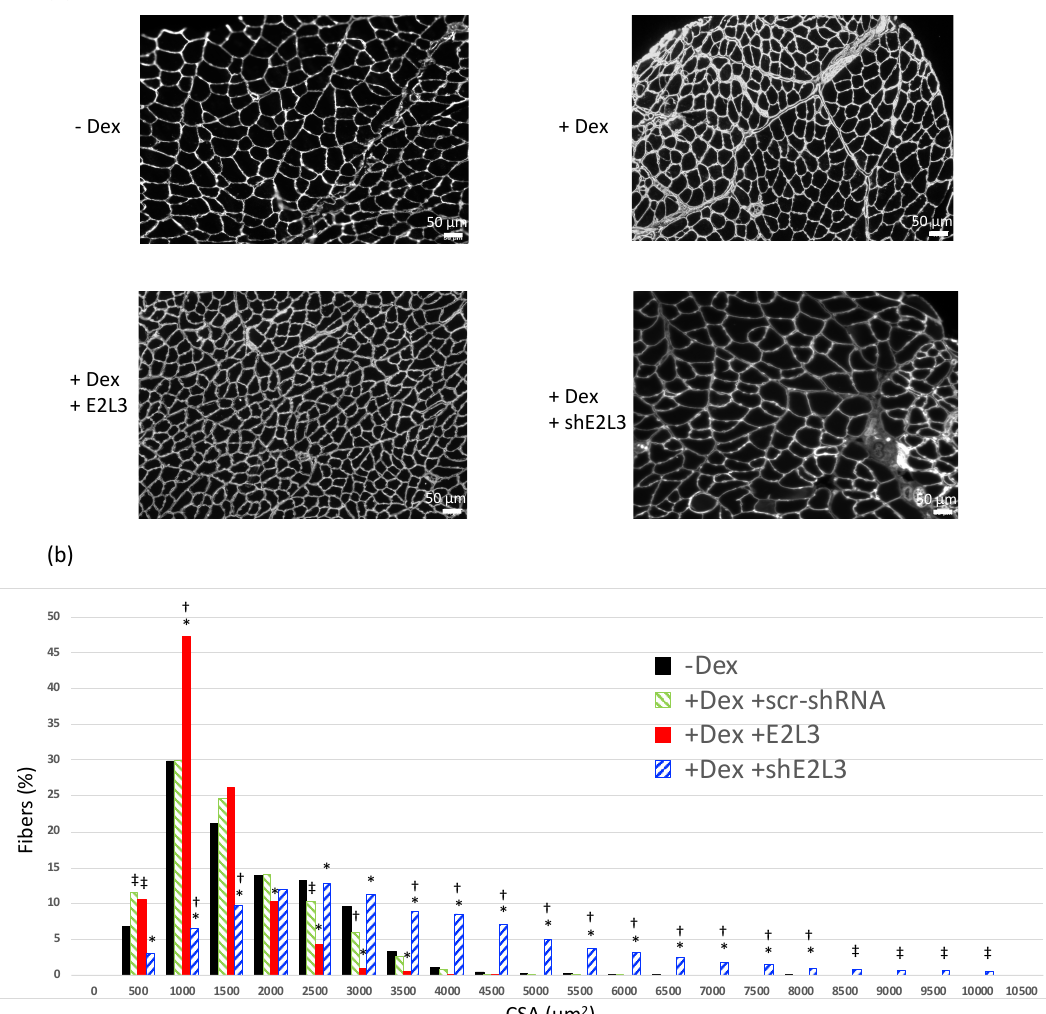
Figure 2. E2L3 KD and overexpression modify myofiber cross-sectional area (CSA). Mice treated or not with Dexamethasone (Dex 5 mg/kg/day) were transfected with either a scramble shRNA (scr-shRNA) targeting no known coding sequence, a mixture of two shRNAs (siE2L3, knockdown) directed against E2L3 or a plasmid encoding for E2L3 (E2L3, overexpression). Sh-encoding plasmids also encoded for emGFP, which allowed us to estimate the efficiency of transfection (typically around 50%; see Supplementary Materials Figure S2). Tibialis anterior muscle cross-sections were labeled with anti-laminin- α 1 for determining CSA (see Section 2 for details). Four different zones and a minimum of 380 fibers were used for each muscle. ( a ) Representative cross-sections of T. anterior from each group are shown. Scale bar, 50 µ m. ( b ) CSA analysis from n = 6 mice and a total of 17,945 fibers were analyzed, using a one-way ANOVA. Fibers distribution was analyzed within each muscle by grouping CSAs by 500 µ m 2 steps. A global shift towards lower CSA was observed when E2L3 was overexpressed in muscles. By contrast, larger CSA were observed in E2L3 KD muscles when compared to controls; n = 6 mice per group. * Statistically different from scr-shRNA group, p < 0.05. Statistically different from non-treated (-Dex) group, † p < 0.05, ‡ p <